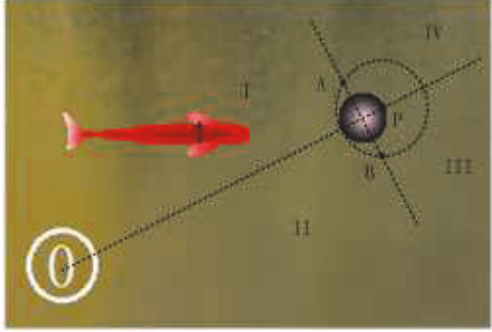
Figure 4: Determination of hitting point.